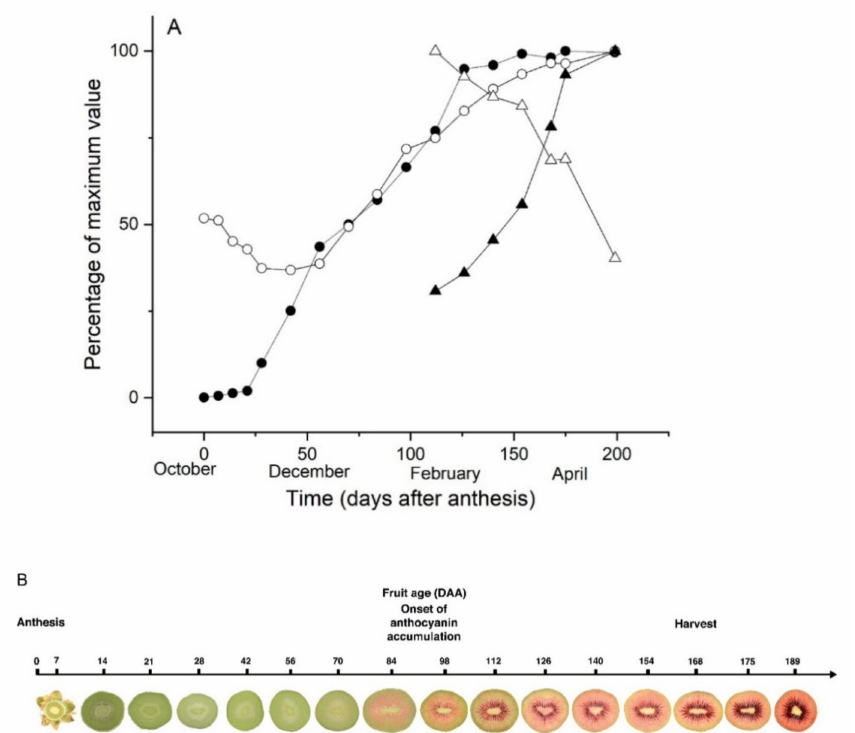
Figure 7. Development of Actinidia chinensis var. chinensis ‘Zes008’ fruit from anthesis until maturity. ( A ) Physiological changes in fruit were normalised as a percentage of the maximum value for fruit fresh weight • , fruit dry matter , soluble solids concentration (cid:78) , and fruit firmness (cid:52) over the (cid:35) growing season. Data are means ± SEM, n = 15. ( B ) Cross sections of typical fruit throughout development (not to